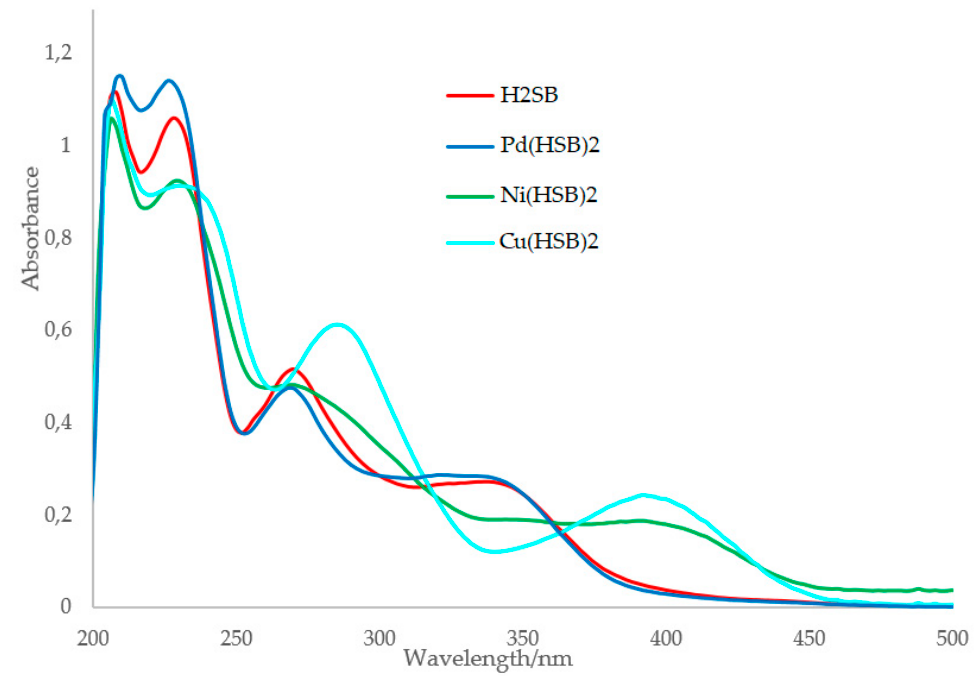
Figure 5. Absorption spectra of H 2 SB, Pd(HSB) 2 , Ni(HSB)2 and Cu(HSB)2 using a methanol-water solution as solvent (in 80:20 v/v).